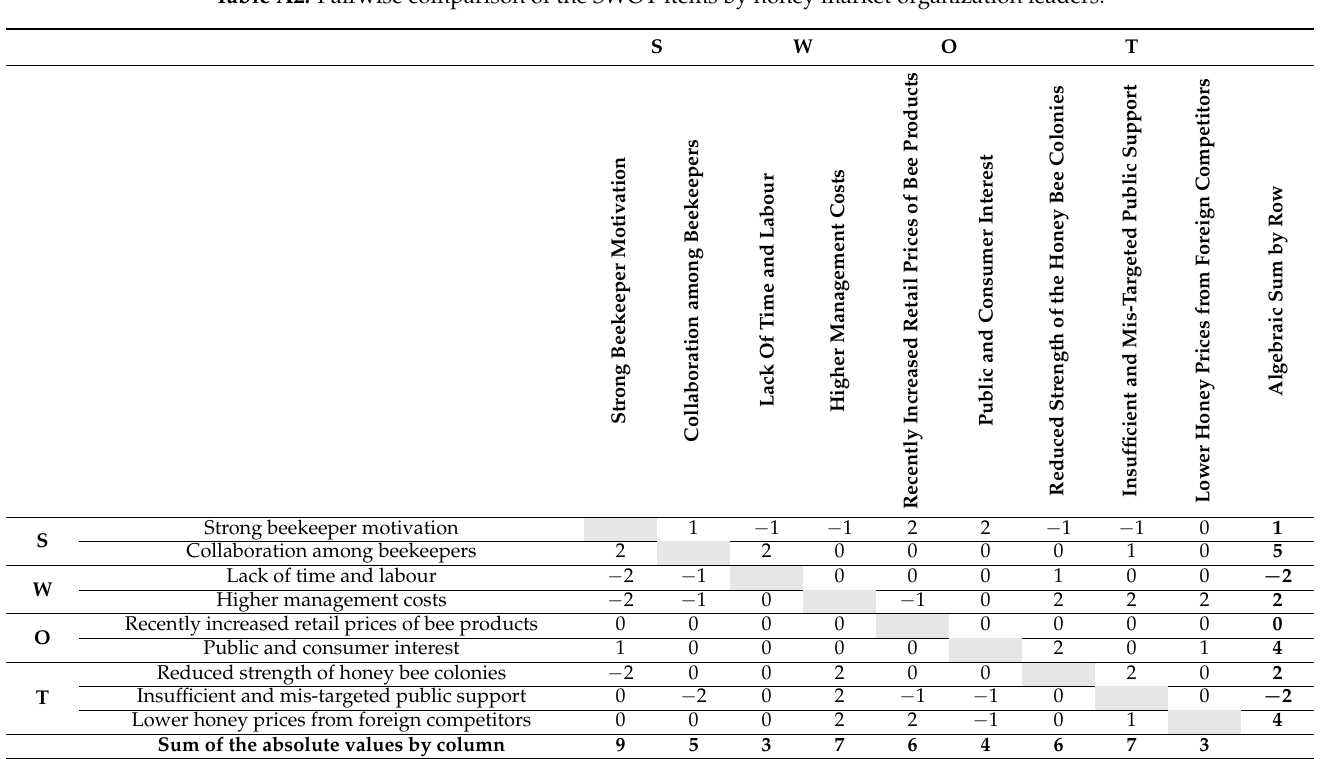
Table A2. Pairwise comparison of the SWOT items by honey market organization